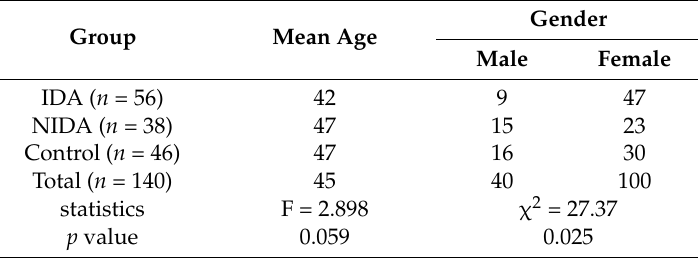
Table 1. The distribution of age and gender in three groups.